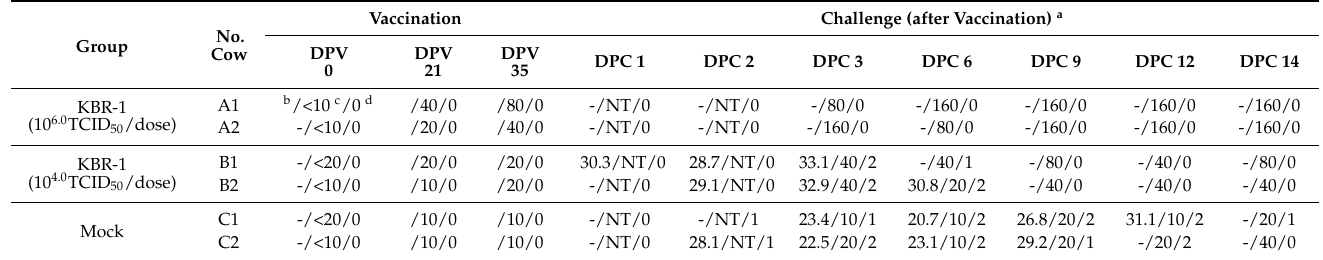
Table 4. Detection of BCoV antigen and antibodies, and diarrhea scores after vaccination and chal ‐ lenge with BCoV KBR ‐ 1.